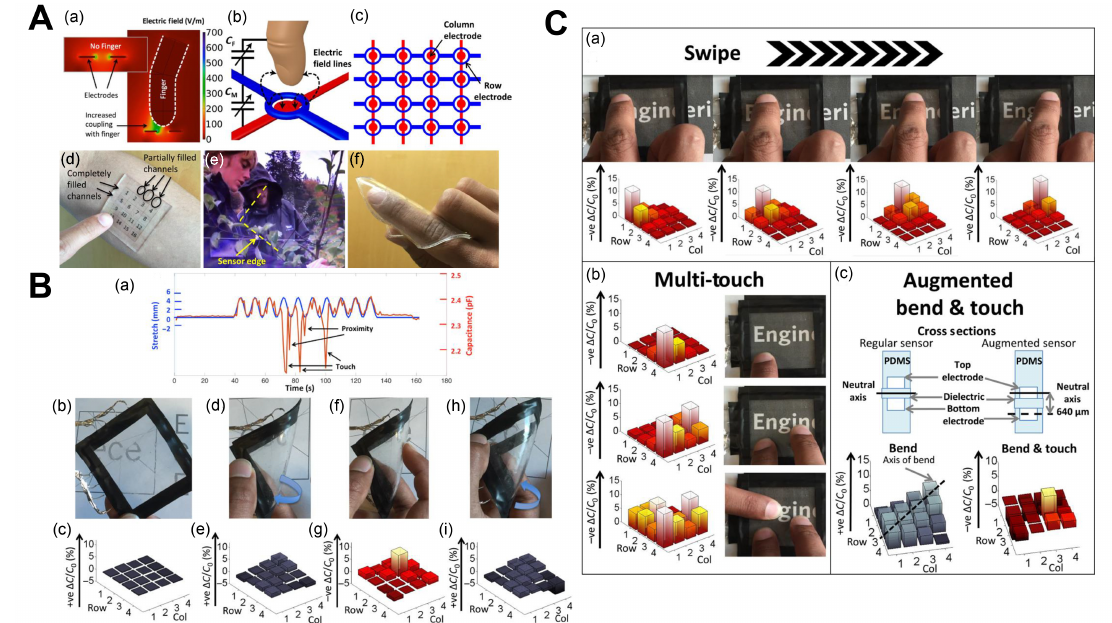
Figure 8. A touch sensor using stretchable and ionically conductive hydrogel electrodes, which project electric field above the sensor to couple with and sense a finger. ( A ) Working principle and properties of the touch sensor; ( B ) touching the sensor while sensing and bending; and ( C ) multi-touch, swipe, and augmented bend detection. Reproduced with permission from [190]. Copyright 2017,